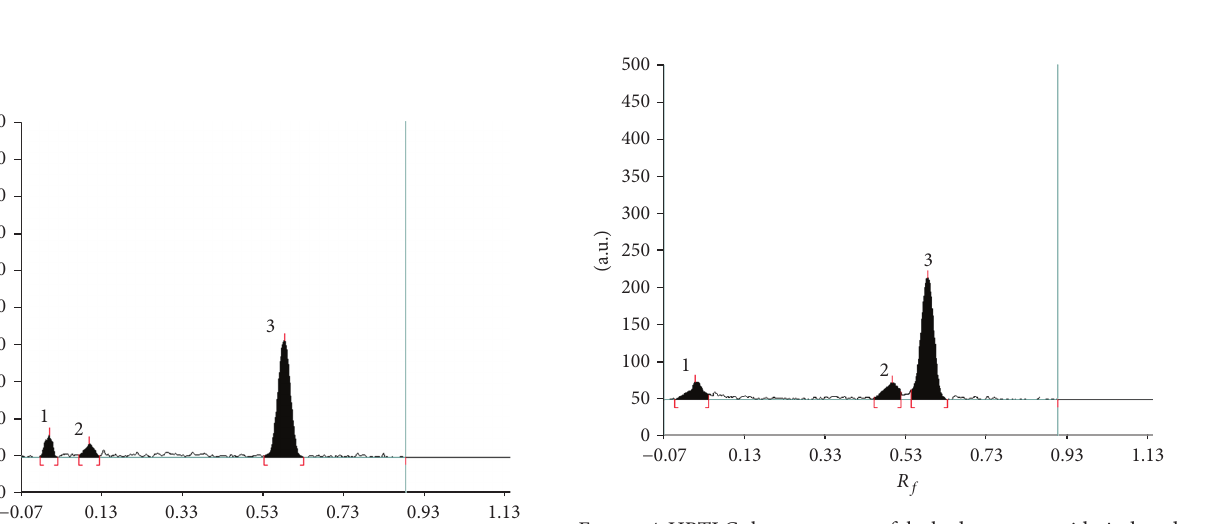
F4:HPTLCchromatogramofthehydrogenperoxide-induced degradation of LAM